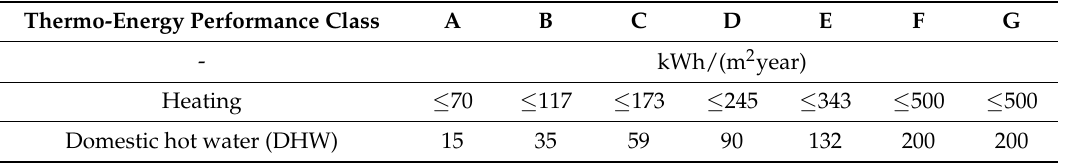
Table 3. The thermo-energy classification for buildings [48].